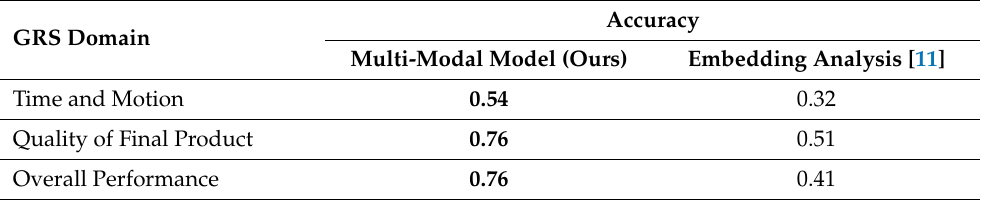
Table 9. Accuracy of the multi-modal model, determined by first rounding the continuous ground- truth and predicted scores. Best performing model on the JIGSAWS dataset included as reference